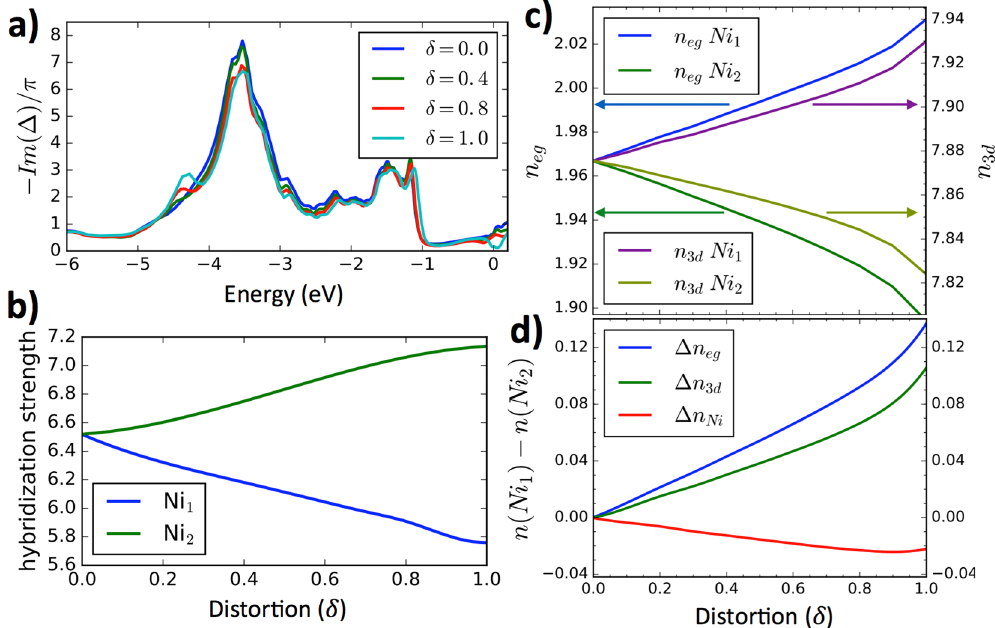
Figure 2. Hybridization and charge of Ni ions. ( a ) Energy dependent hybridization function of the Ni 1 ion at few values of the distortion parameter δ ∈ (0, 1). ( b ) The integral of the hybridization function (in the displayed energy window) as a function of distortion parameter δ . ( c ) The charge density on the two Ni atoms corresponding to the e g orbitals and the entire 3 d shell. ( d ) The difference of the charge between Ni 1 and Ni 2 in the e g orbital, in the 3 d shell, and in the entire muffin-tin sphere corresponding to Ni